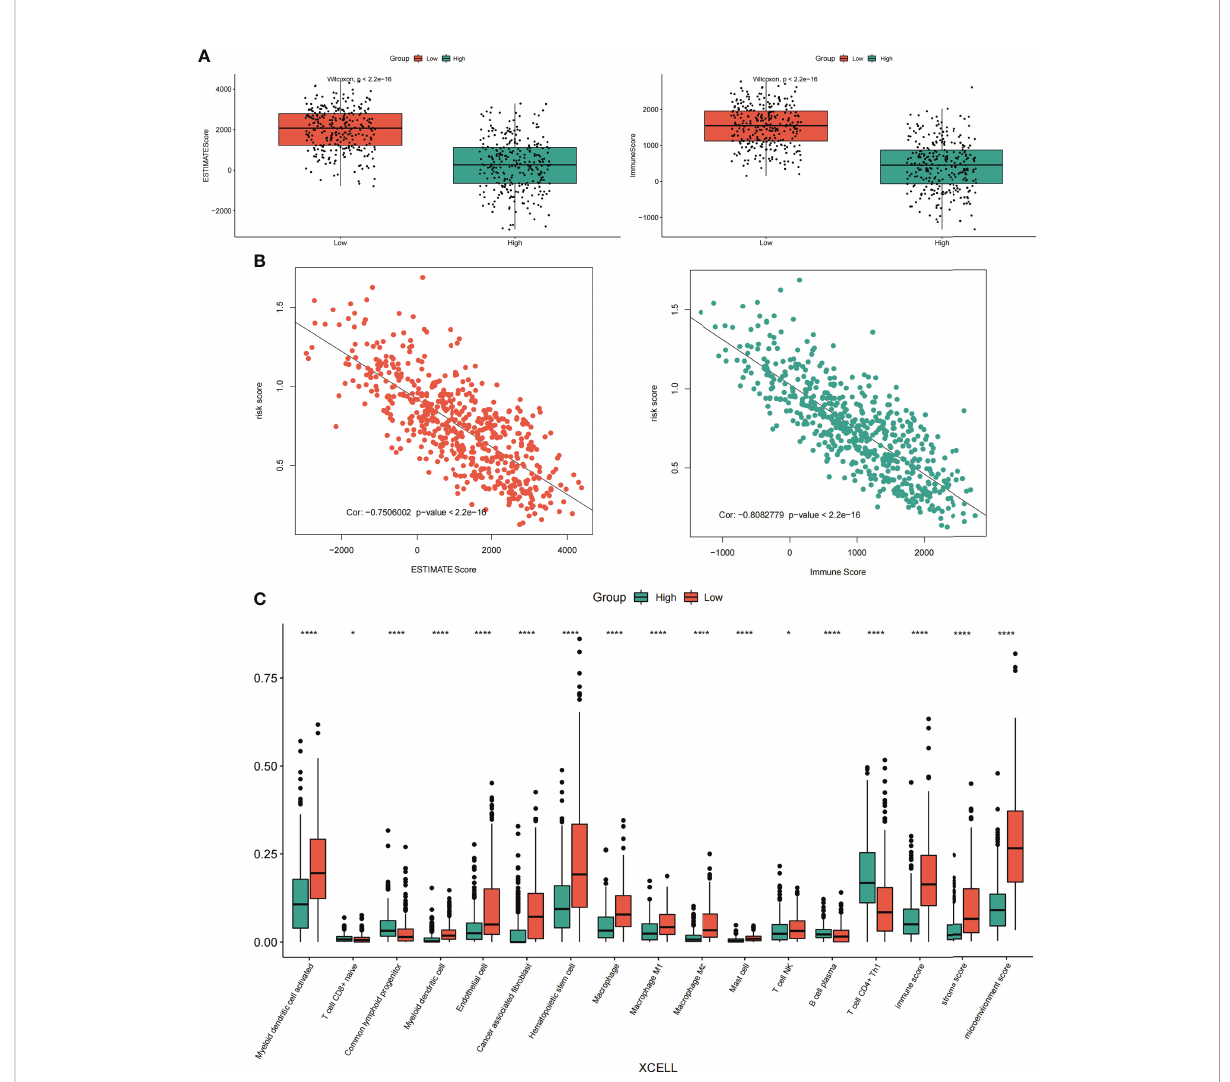
FIGURE 11 Correlation analysis of risk score, immune score and immune in fi ltrating cells. (A) Differential expression of ImmuneScore and EstimateScore scores in the high-low risk groups of LUAD samples. (B) Correlation analysis between ImmuneScore and EstimateScore scores and LUAD sample risk score. (C) The expression differences of different immune cell in fi ltrates between the high and low-risk groups were analyzed by the XCELL algorithm. *p < 0.05, ****p <